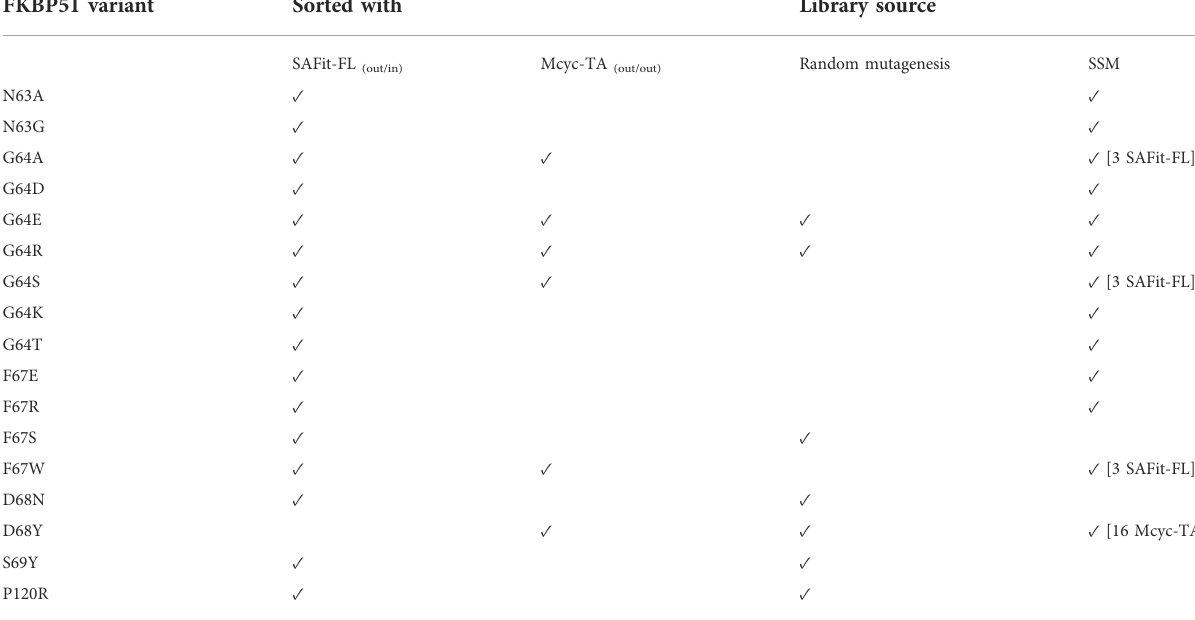
TABLE 1 Identi fi ed FKBP51 variants after FACS sorting of the random mutagenesis and SSM yeast library with SAFit-FL (out/in) or Mcyc-TA tracers. FKBP51 variant